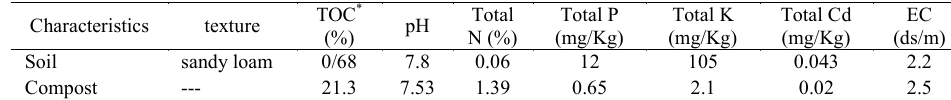
Table 2: Characteristics of soil and organic matter